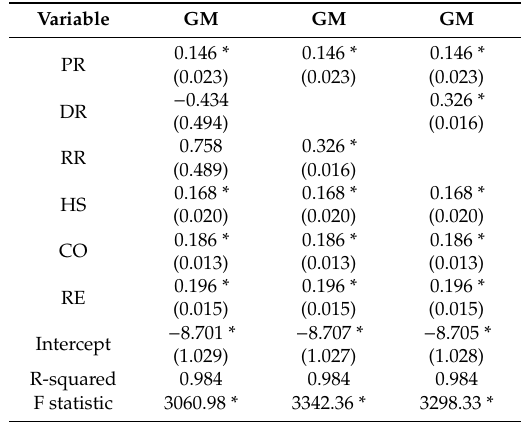
Table 8. Ordinal score of GM regressed on six category ordinal rankings.